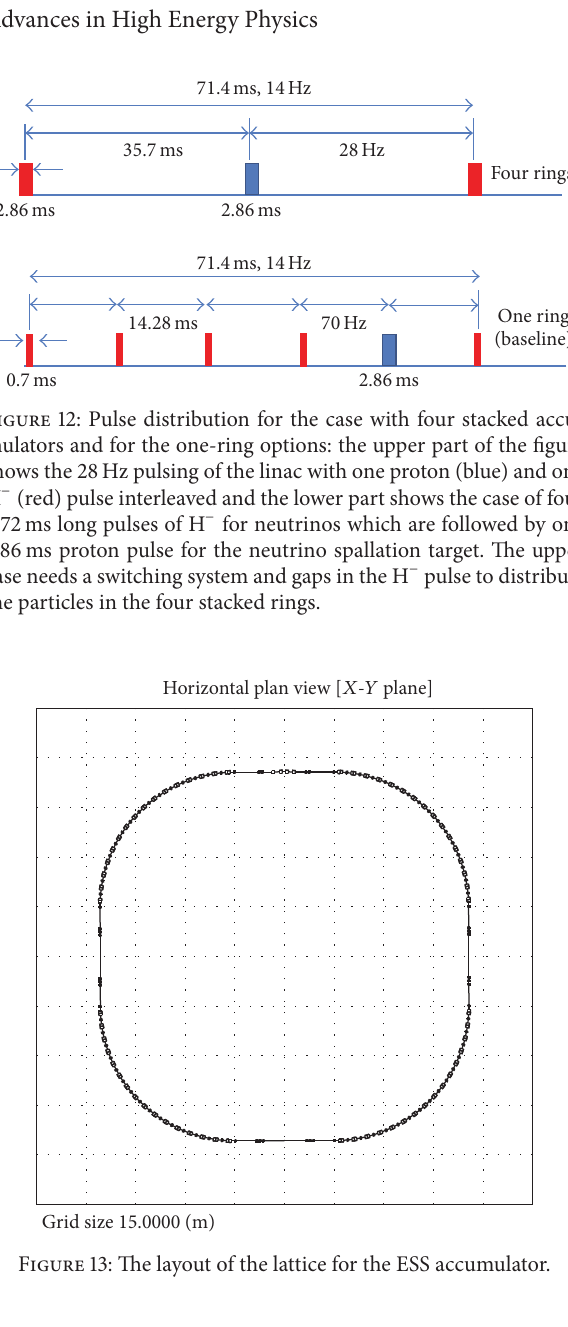
wall plug power for 14 pulses of 2.86 ms per second. In